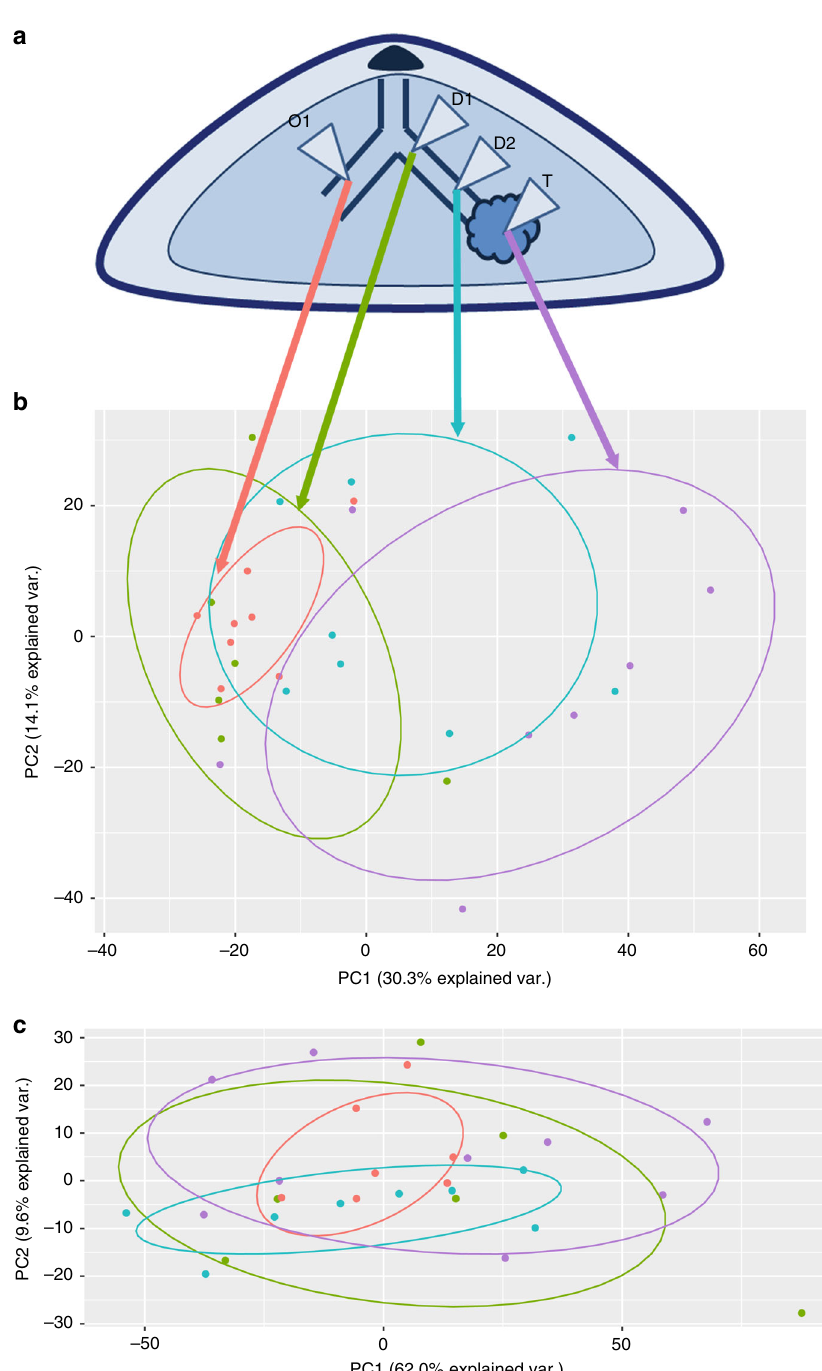
Fig. 1 The fi rst principal component of gene expression directly corresponds to proximity to tumour. a Schematic of the relative locations of all epithelial sample extractions, with the nipple and tumour highlighted. Samples D1 and D2 were obtained along the duct, approaching the tumour. Sample O1 is an epithelial sample from a breast duct on the other side of the nipple. b Biplot of the fi rst two principal components of the expression matrix, limited to top 10% most varied genes. This proximity-based separation between epithelial samples is observed with the biplot including all genes, but is clearest here. c Biplot for the corresponding aCGH data; with no proximity-to-tumour separation in either of the fi rst two principal components. PC, principal